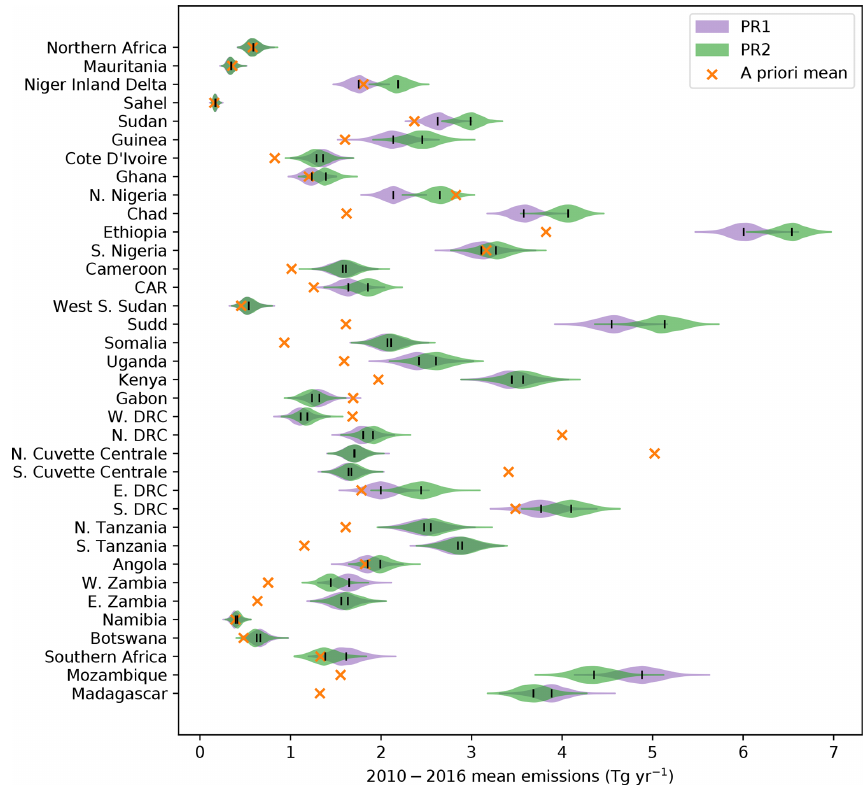
Figure 4. Violin plot of the a posteriori distribution from each African basis function for the PR1 (purple) and PR2 (green) inversions over 2010–2016. The lines in the centre of the violins represent the mean of each respective distribution. The a priori mean value for each basis function region is shown by the orange cross. Basis function regions are ordered from south to north travelling up the y axis. The region names on the y axis are intended to be representative of the respective regions and not necessarily an exact definition based on country borders. CAR is the Central African Republic. DRC is the Democratic Republic of the